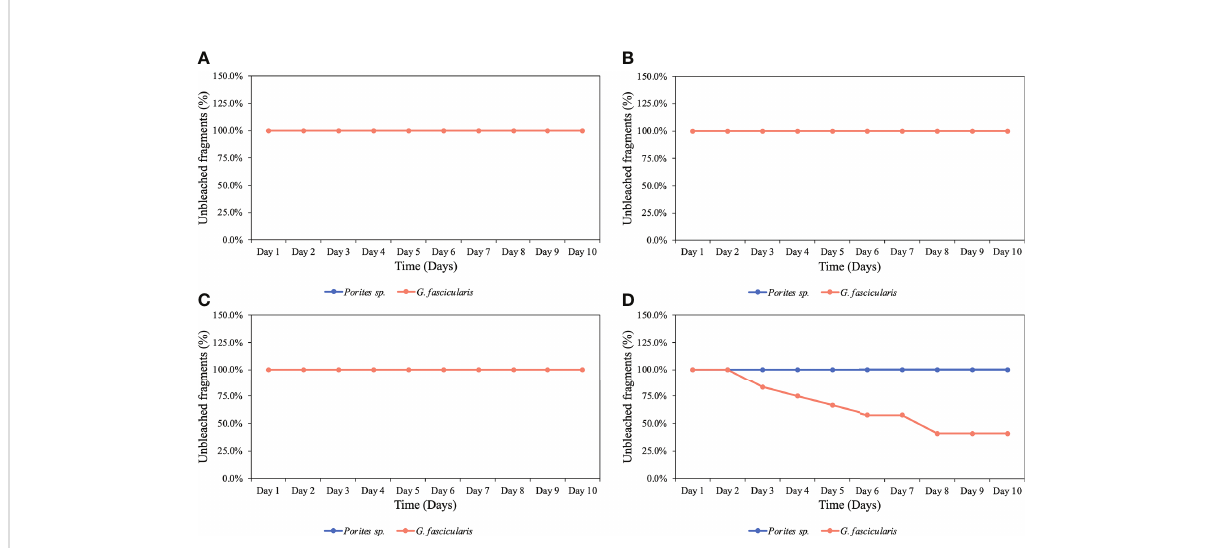
FIGURE 1 Percentage of unbleached coral fragments throughout the complete experiments for both species. (A) Control (6.8 mg O 2 L − 1 ), (B) high O 2 treatment (5.25 mg O exposure to the low O 2